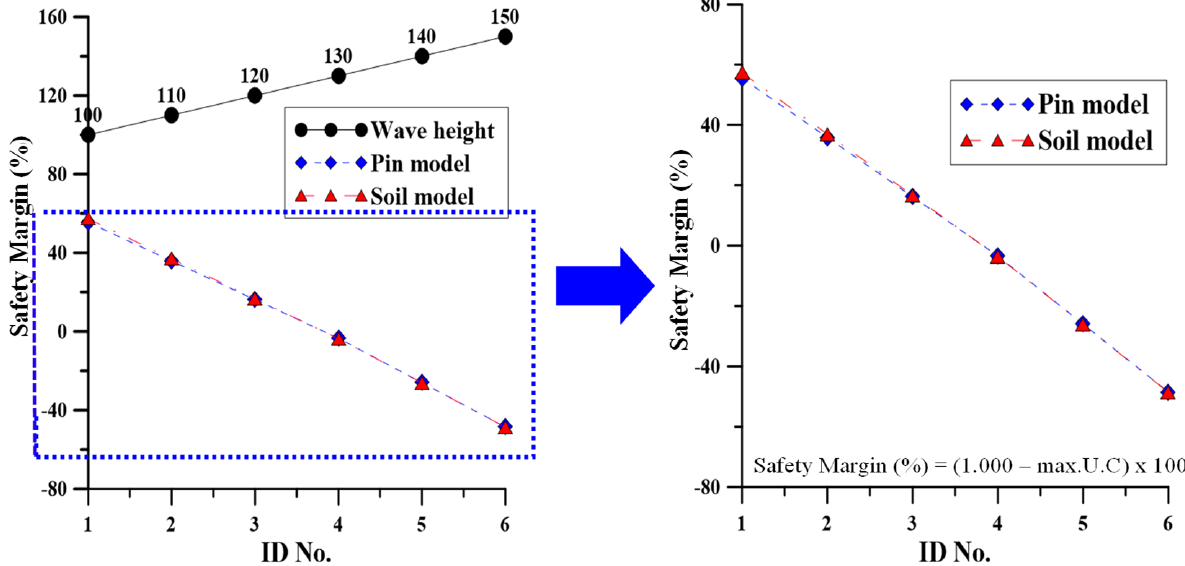
Figure 9. Comparative unit check margin with varying wave height.